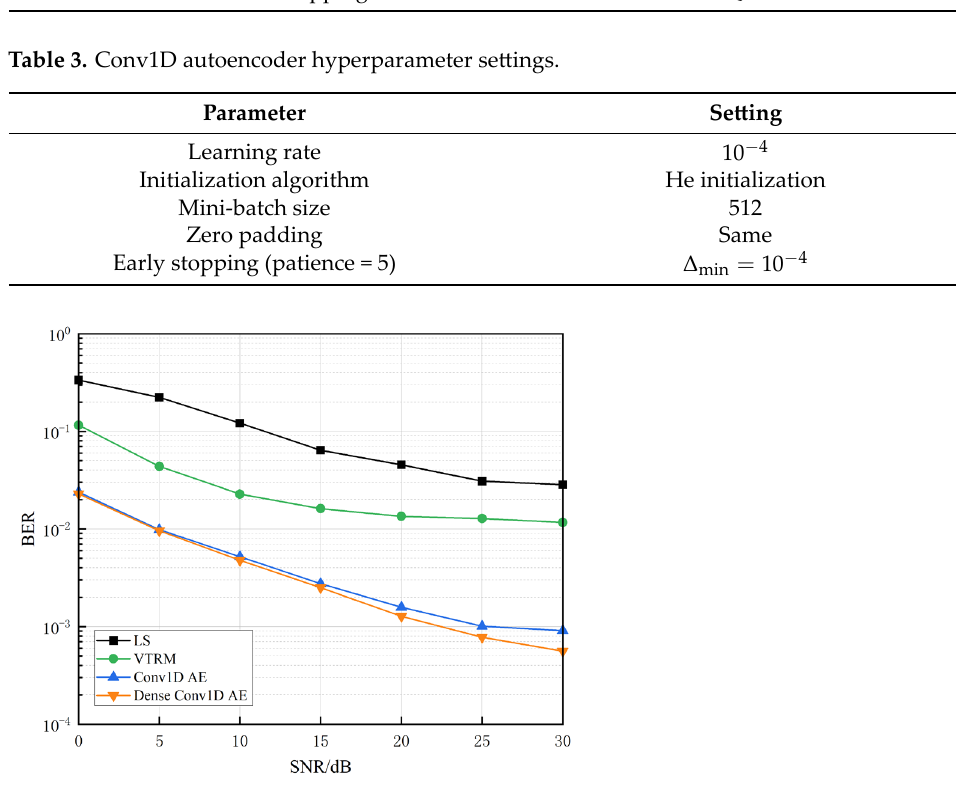
tions compared with the traditional algorithm.